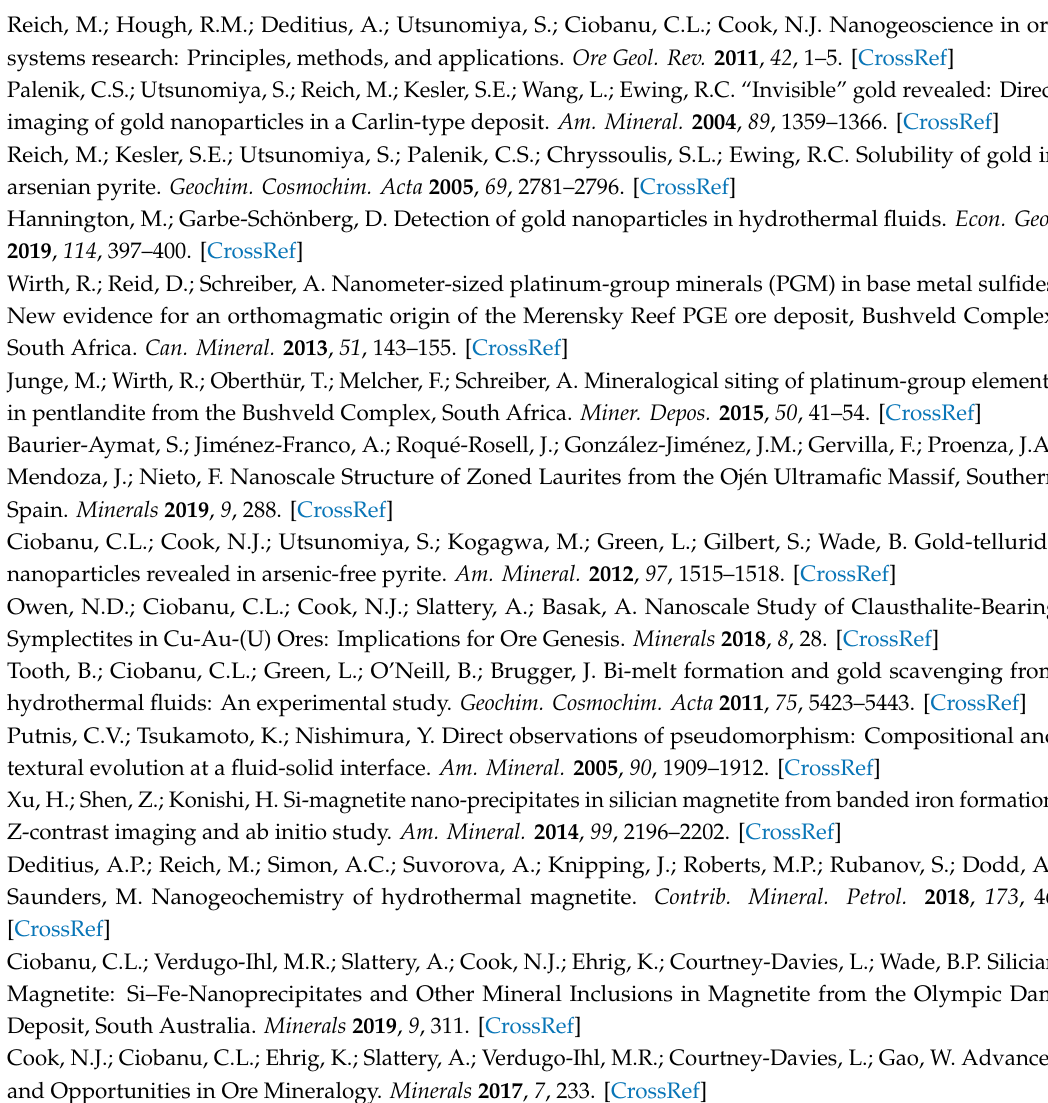
Figure S7. Representative STEM EDX spectra for observed NPs within cavities or directly hosted by hematite. The spectra are scaled individually to emphasise features of interest; typical hematite spectrum is shown (top left) for comparison. Note the relative di ff erences between the Fe-K and Cu-K intensities in hematite host relative to the Cu-As-bearing